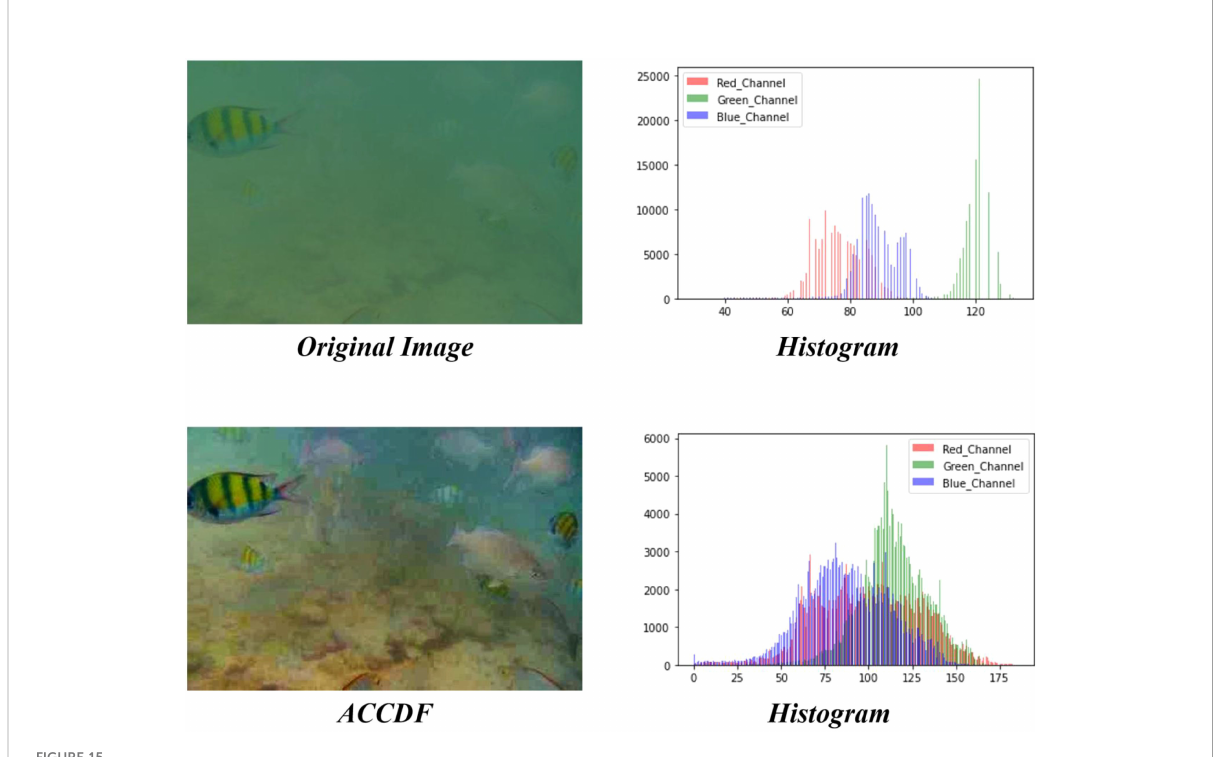
FIGURE 15 Histogram comparison of Figure